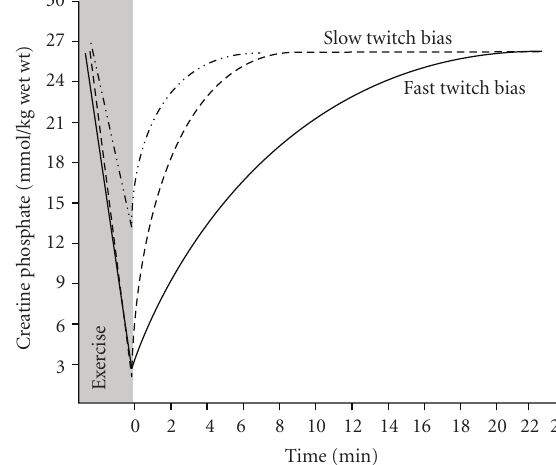
Figure 6: Representative kinetics of creatine phosphate (CrP) recovery in subjects with di ff erent end exercise CrP concentrations and di ff erent proportions (bias) of slow or fast twitch muscle. Note the more rapid recovery of CrP when there is less exercise-induced depletion (- ·· - ·· ) versus near complete depletion (- - - -). Based on unpublished research observations of the authors.